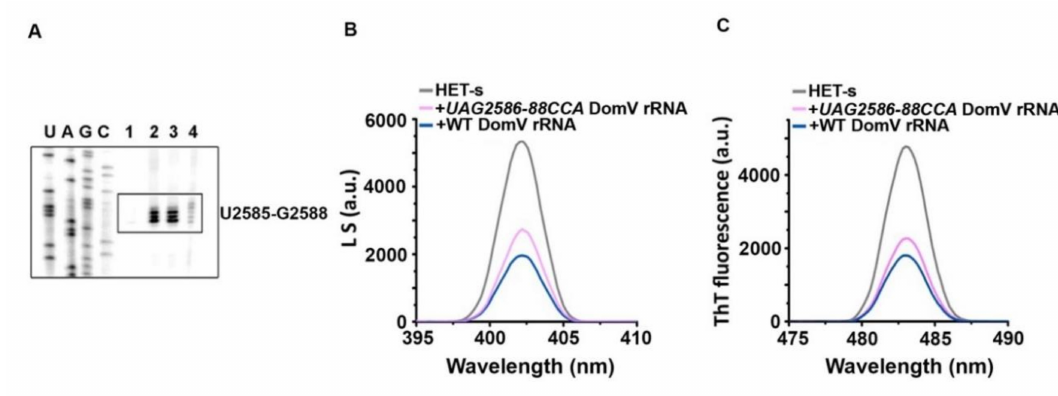
Figure 6. The e ff ect of UAG2586–88CCA mutation in domain V rRNA on HET-s aggregation and interaction map . ( A ) The primer extension map of sections of domain V of 23S rRNA ( E. coli) without any protein ( Lane 1 ) or with HET-s UV cross-linked to wild-type ( Lane 2 ), or mutant domain V rRNA with mutations UU2561–62AA ( Lane 3 ) and UAG2586-88CCA ( Lane 4 ). Only the road-block site U2585-G2588 is shown in the box; ( B , C ) HET-s aggregation with UAG2586-88CCA mutant variant of domain V rRNA checked by light scattering ( B ) and ThT binding ( C ) using the setting described in materials and methods. Figures are representative of three independent